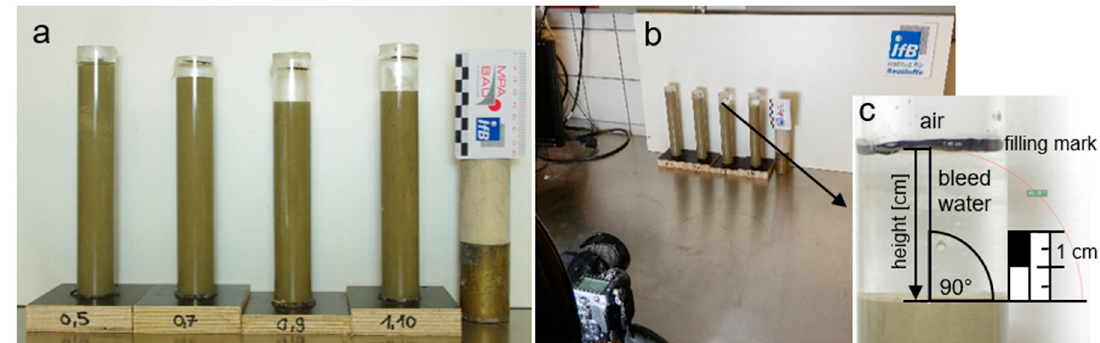
Figure 2. ( a ) Acrylic glass cylinders filled with cement suspension samples; ( b ) experimental set-up for the bleeding measurements on cement suspension samples and ( c ) example image of bleed water height.